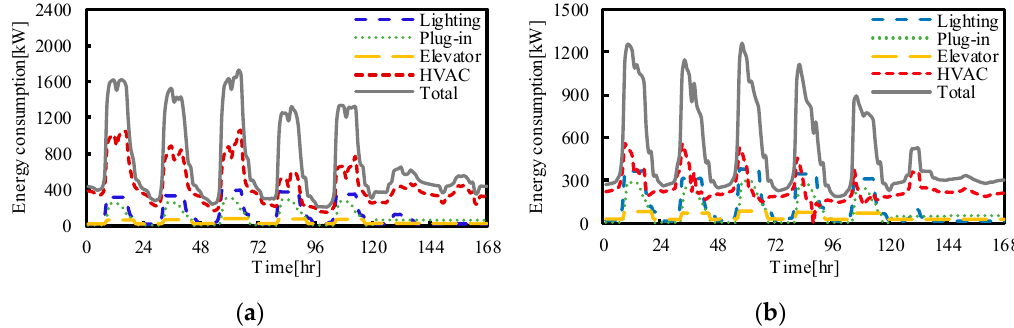
Figure 4. The total loads and loads of four types of subsystems in a typical week for ( a ) summer and ( b ) winter.